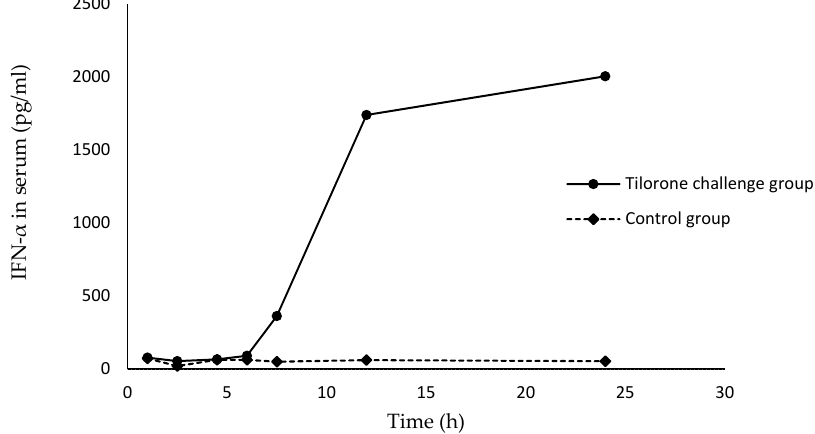
Figure 2. Serum IFN- α response of mice to tilorone dihydrochloride ( 1 ).